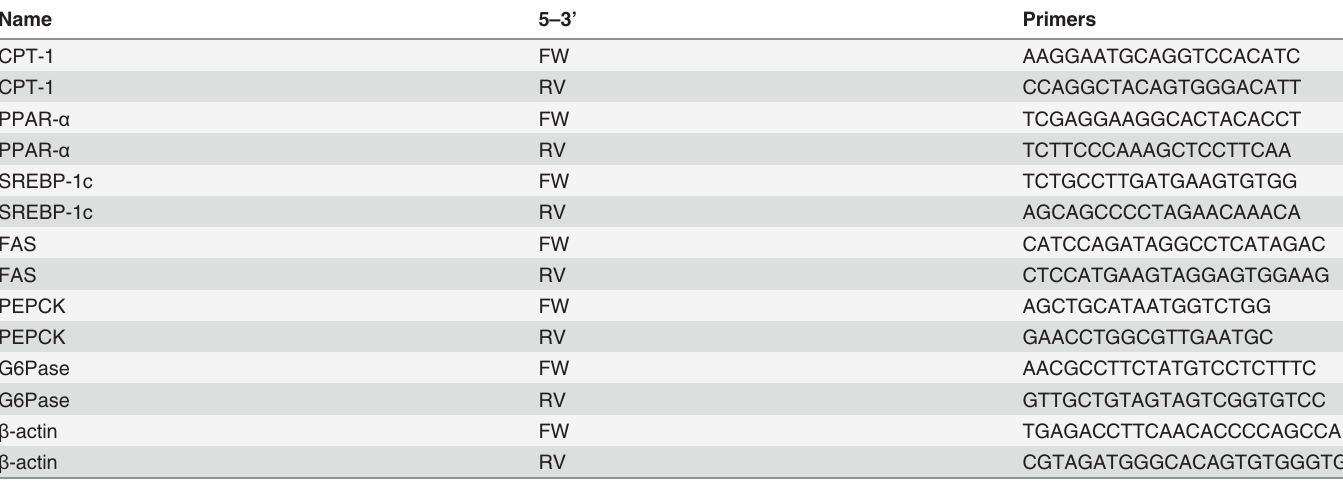
Table 2. RT-qPCR primers and respective